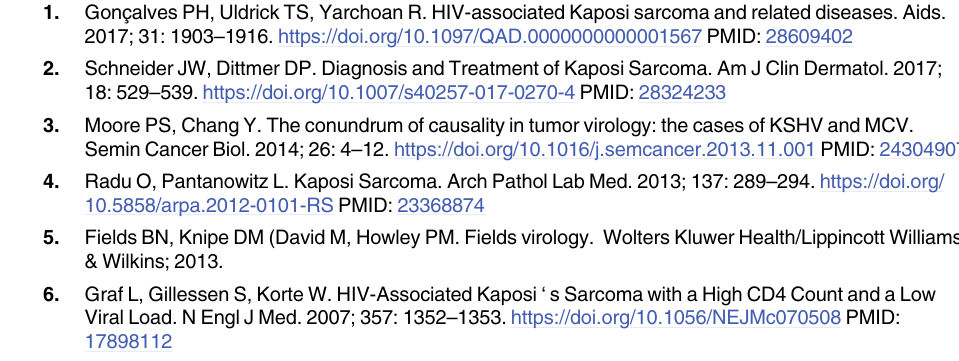
(ZIP) S1 Graphs. 30 graphs of probabilities and scores of predicted non-B-DNA structures 500 bp before and after individual breakpoints examined in the manuscript. The coordinate numbers in the figures of some breakpoints differ slightly from those in Column D of S2 Table because working draft genomes were used for non-B-DNA analyses, while S2 Table lists coor- dinates in the finished genomes uploaded to Genbank. The coordinate differences come from refinements in the genome termini and repeat regions, outside the analyzed